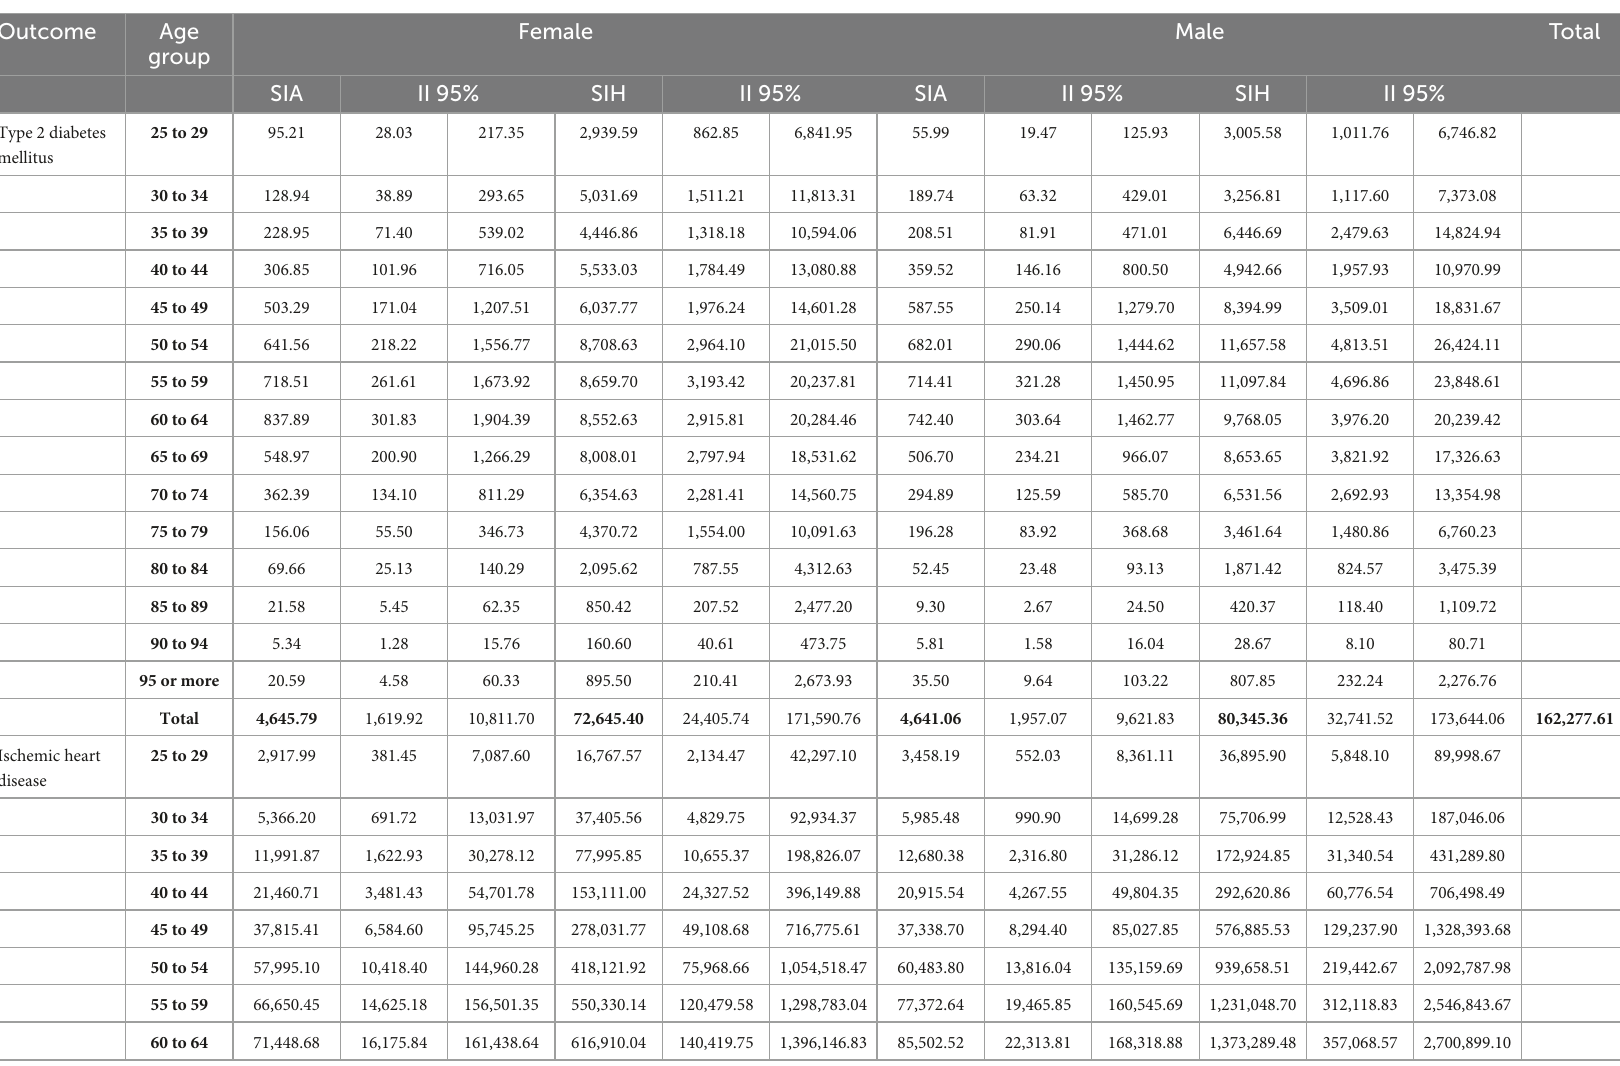
TABLE 2 Financial costs of hospitalizations and high and medium complexity procedures for NCDs attributed to the consumption of SSBs, in international dollars (US$), by age group, sex, and outcomes, Brazil, 2019, SIA and SIH, according to GBD 2019.